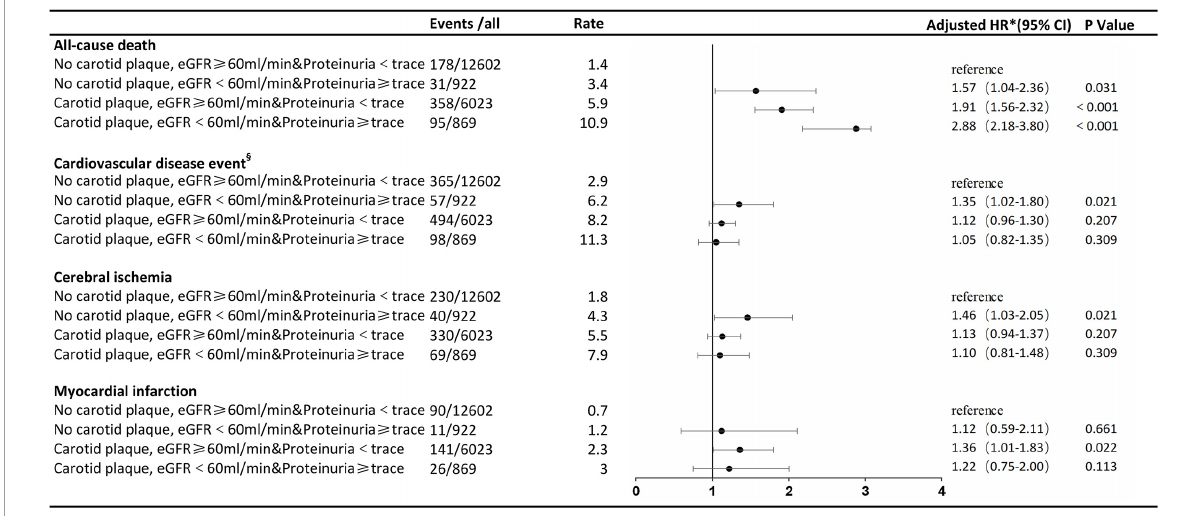
FIGURE2 Association of carotid plaque and renal impairment with all-cause death and cardiovascular disease events. § Cerebral ischemia or myocardial infarction. *The model was adjusted for age, sex, smoking, alcohol, body mass index, fasting blood glucose, total cholesterol, low-density lipoprotein-cholesterol, systolic blood pressure, diastolic blood pressure, antihypertensive drug use, and lipid-lowering drug use. eGFR, estimated glomerular filtration rate; HR, hazard